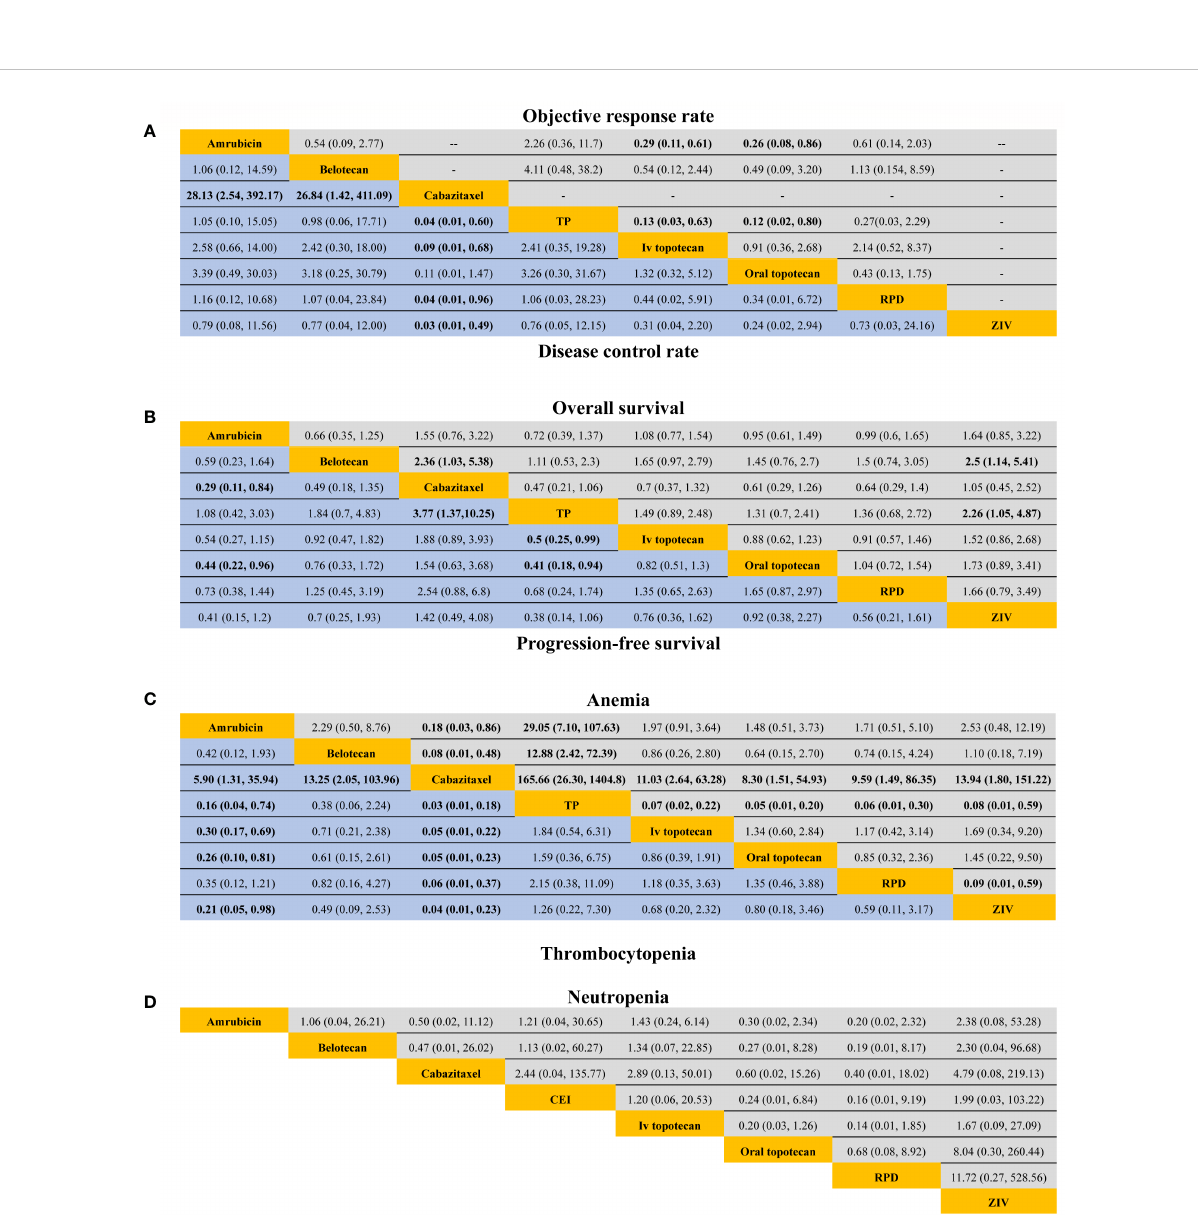
FIGURE 2 Ef fi cacy and safety pro fi les in patients sensitive to previous platinum-based chemotherapy. (A) Odds ratio and 95% CIs for objective response rate (upper area in grey) and disease control rate (lower area in blue), and an OR > 1.00 indicates a better ef fi cacy. (B) Hazard ratios and 95% CIs for overall survival (upper area in grey) and progression-free survival (lower area in blue), and a hazard ratio < 1.00 suggests better survival bene fi ts. (C, D) The odds ratio and 95% CIs for hematological complications (anemia, thrombocytopenia, and neutropenia), and an OR < 1.00 indicate better safety.TP, triple therapy containing platinum; RPD, rechallenge of platinum doublet; Ziv, ziv-a fl ibercept plus intravenous